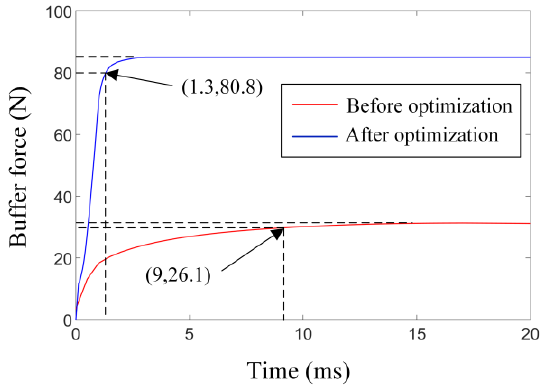
Figure 13. Buffer force curves of the designed VSB.